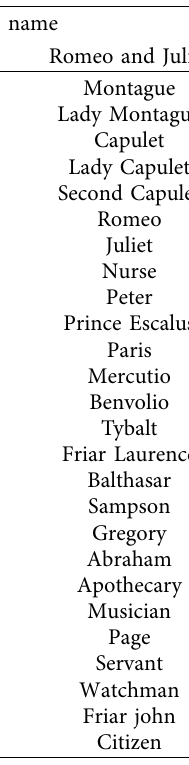
Table 1: Name of the character corresponding to each number.